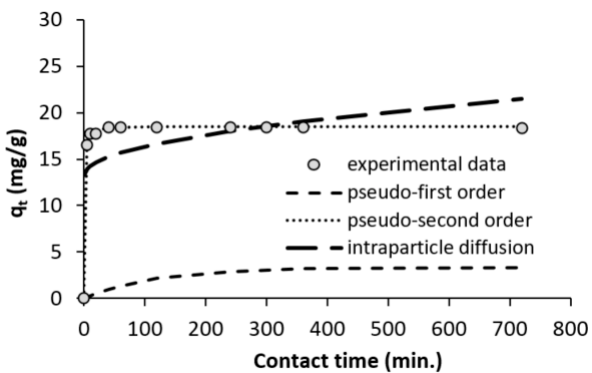
Figure 10. Adsorption kinetics of Cd adsorption onto poultry ash (ash dosage = 5 g / L, Cd concentration = 100 mg / L, pH = 5).